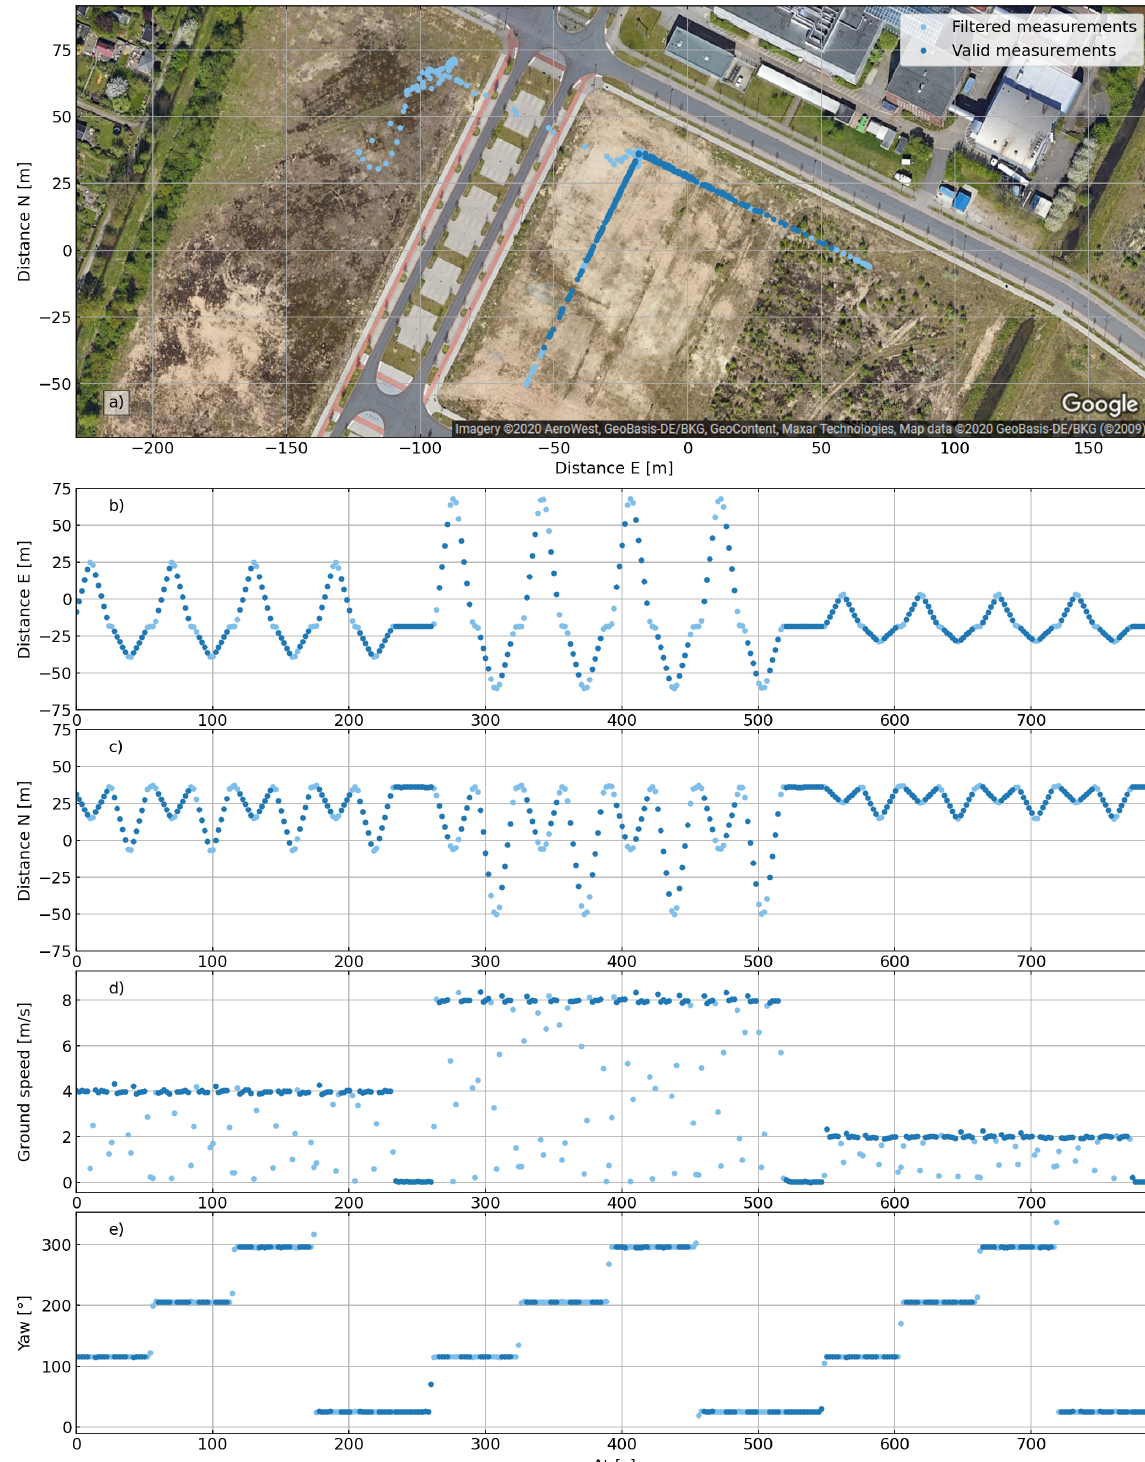
Figure 3. Flight pattern of the anemometer calibration experiment. From top to bottom: location (a) , distance to the (arbitrarily chosen) origin in the east direction (b) , distance to the (arbitrarily chosen) origin in the north direction (c) , ground speed (d) , and yaw (e) of the UAV. Valid measurements are shown in dark blue; filtered measurements are in light blue. The filtering removes measurements that do not lie within the calibration pattern or with UAV accelerations larger than 0.5ms − 2